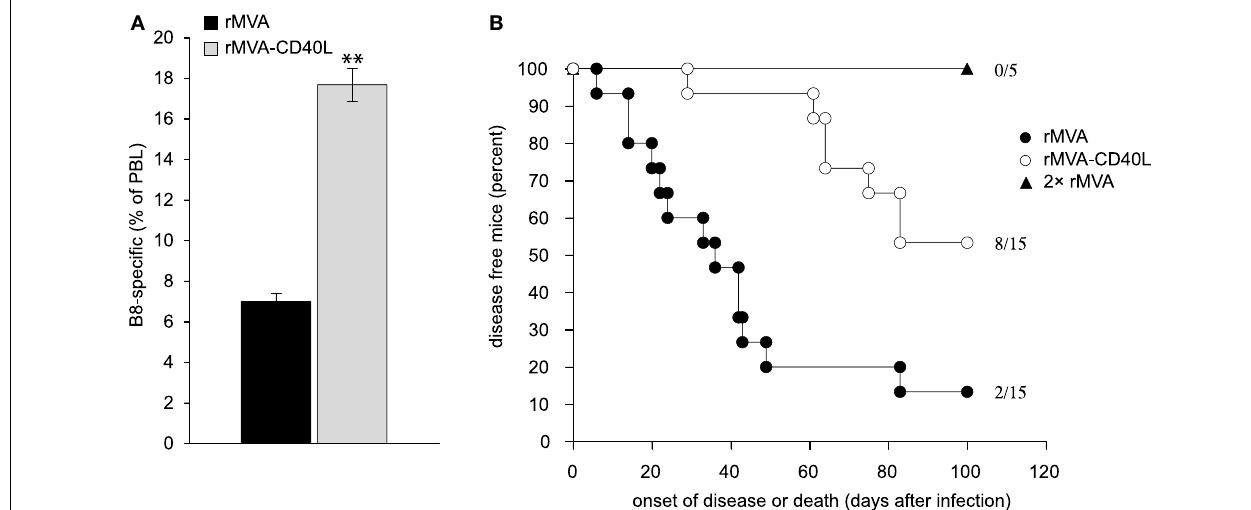
once with rMVA and rMVA-CD40L or twice with rMVA. Approximately 2months after the first immunization, mice were infected with 1 × 10 5 TCID 50 ECTV and monitored daily for disease symptoms and survival. Shown is the day of disease onset or death. Disease onset was defined as the appearance of symptoms such as skin lesions, swollen limbs, and tail or, necrotic skin areas.The data are compiled from three independent experiments.The numbers depict the number of mice that remained symptom-free of the total number of